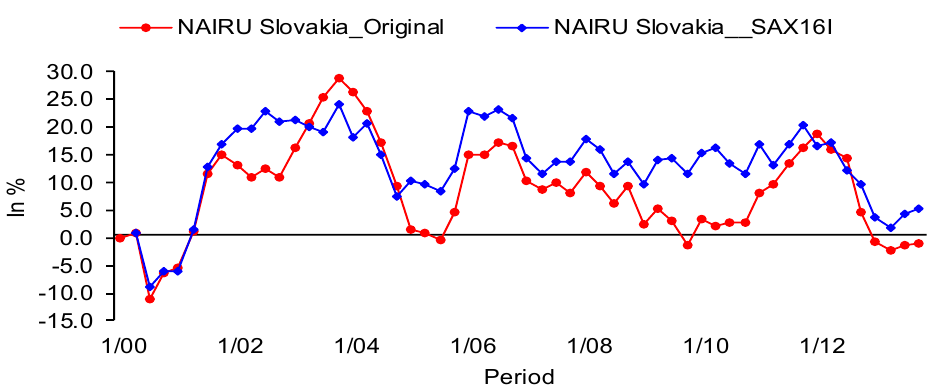
Figure 2. Development NAIRU according to the original model and its enlargement on psychological factor on the supply side in